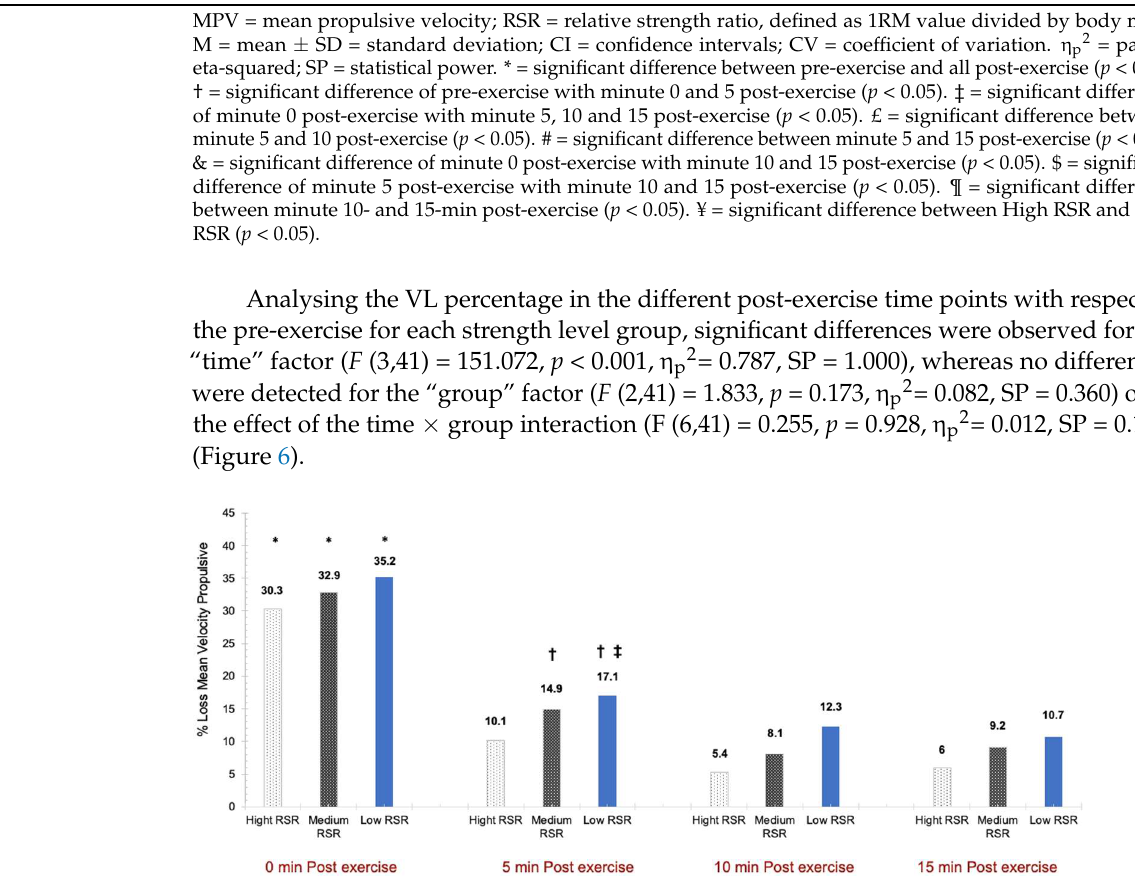
Figure 6. Percentage loss MPV at 1 m · s − 1 at minute 0, minute 5, minute 10 and minute 15 compared to the pre-exercise after the BP exercise protocol. RSR = Relative Strength Ratio. * = significant difference of minutes 0 post-exercise with minutes 5, 10 and 15 post-exercise ( p < 0.05). † = significant difference between minutes 5 and 10 post-exercise ( p < 0.05). ‡ = significant difference between 5- and 15-min post-exercise ( p < 0.05).